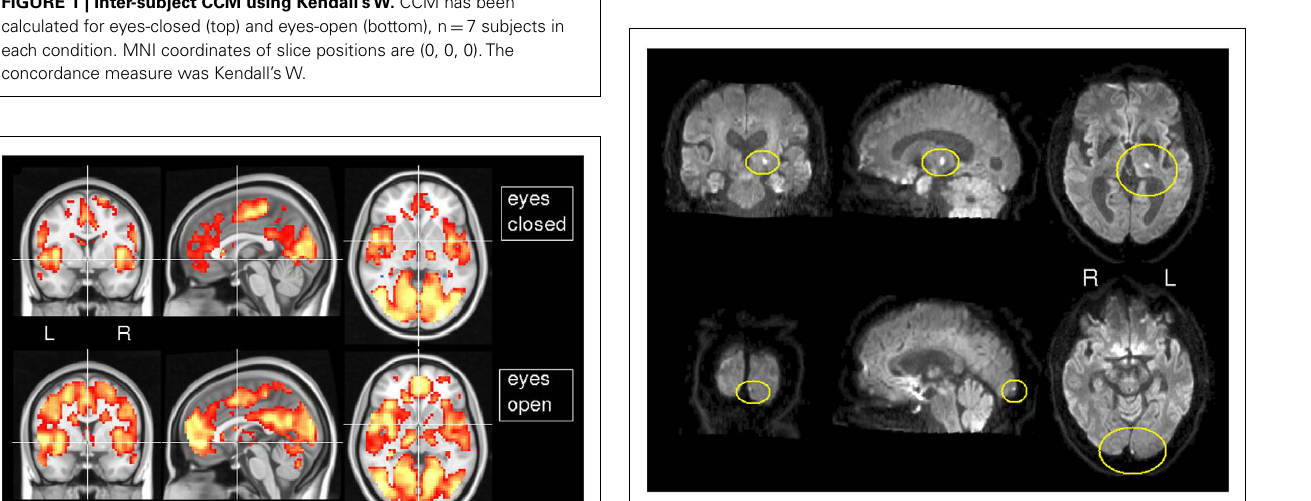
FIGURE 4 | Location of stroke. Diffusion weighted image. Hyper intensities marked in yellow represent the lesioned areas. Lesions are restricted to left thalamus and left occipital